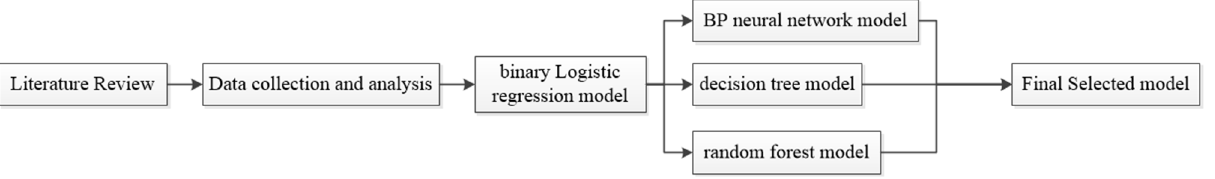
Figure 1. The simple structural framework.